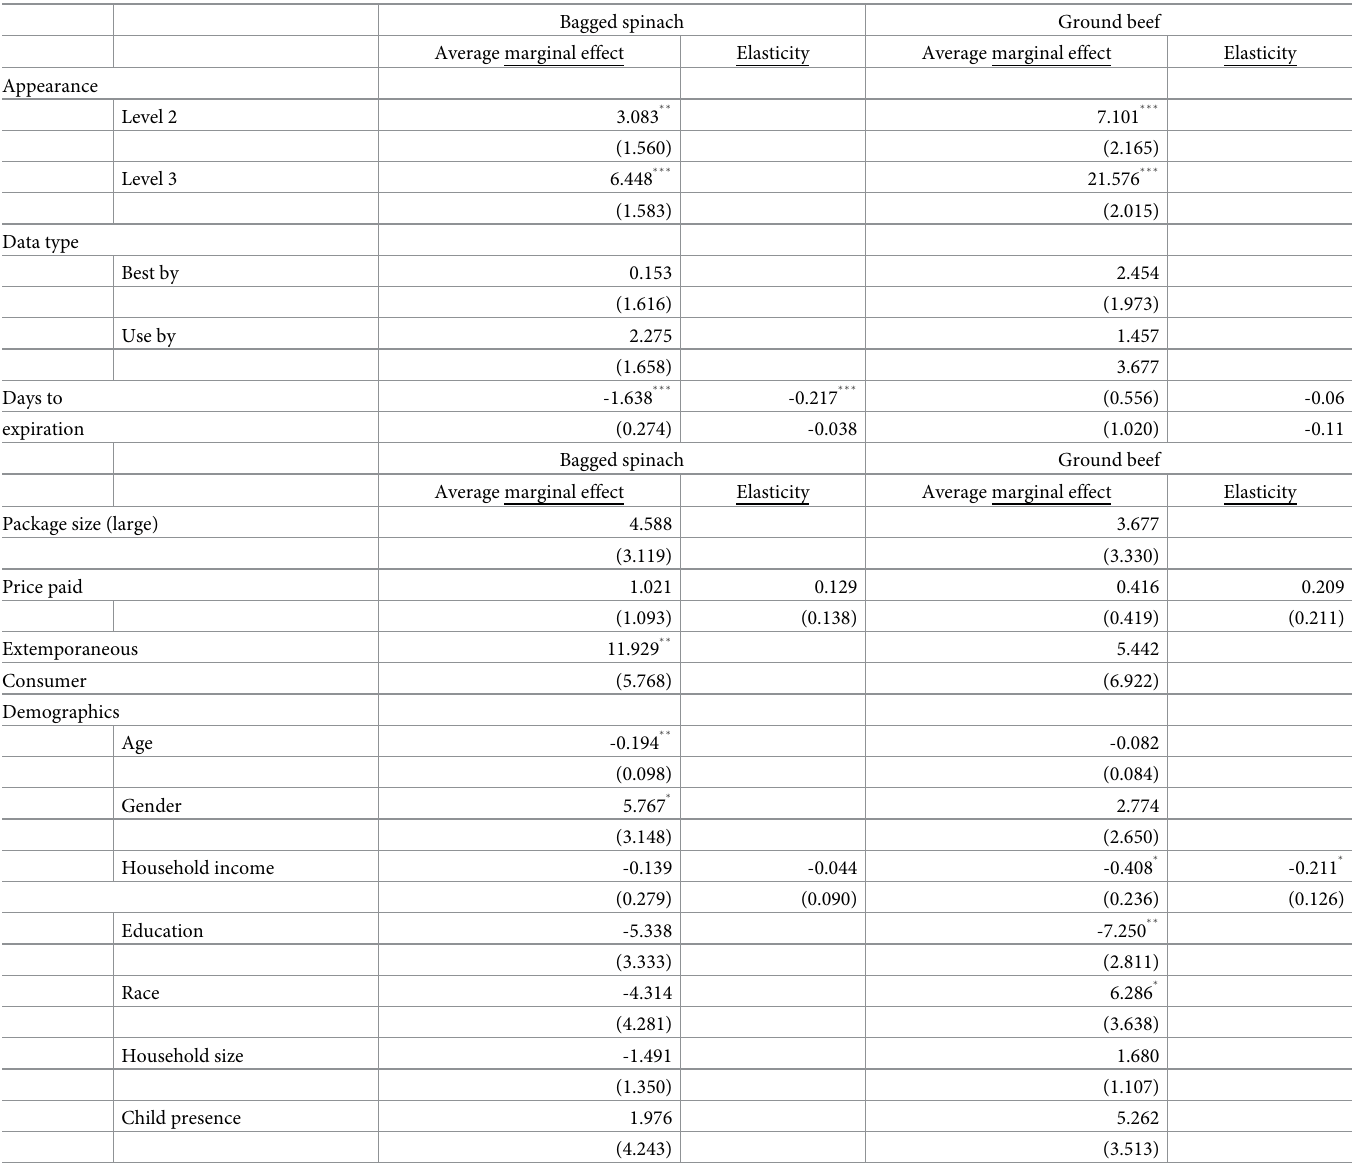
Table 7. Average marginal effects and elasticities a